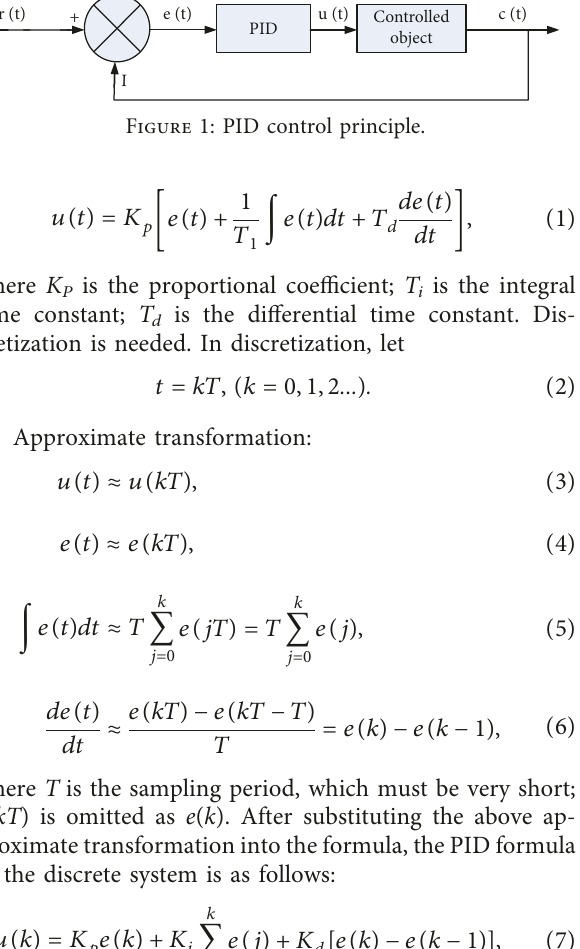
Figure 1: PID control